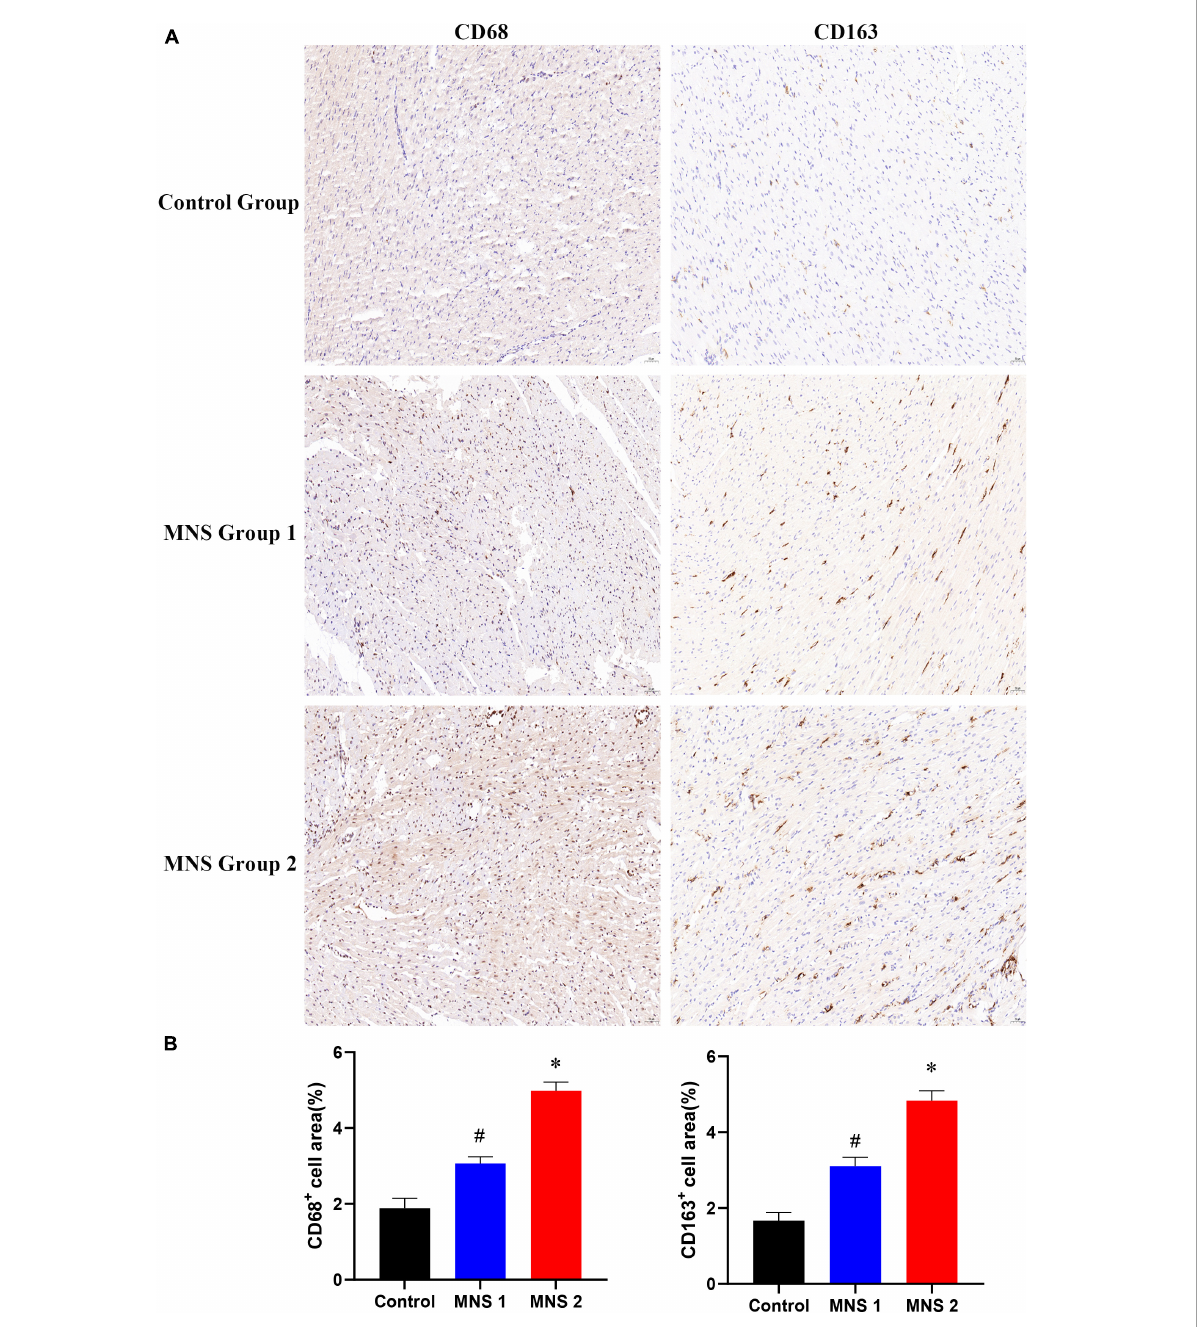
FIGURE7 CD68 and CD163 immunohistochemistry (IHC) of left ventricular myocardial tissue in each group. (A,B) Representative examples and quantitative analyses of CD68 and CD163 expression in the control, MNS group 1, and MNS group 2 dogs. # P < 0.01 vs. control group and MNS group 2; ∗ P < 0.01 vs. control